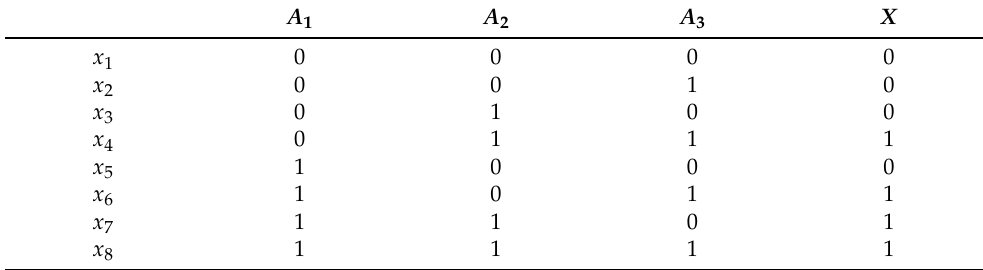
Table 1. A decision information